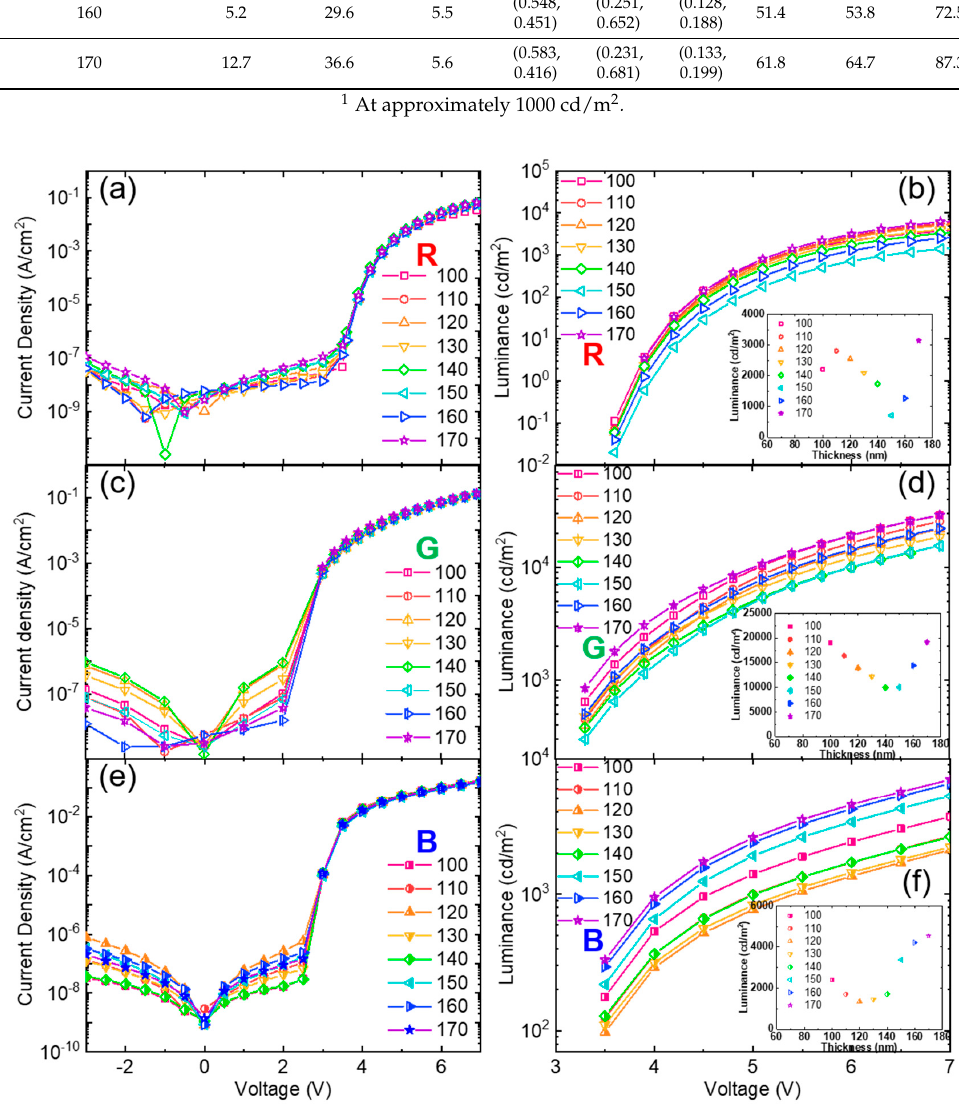
Figure 6. Current density–voltage–luminance ( J - V - L ) characteristics of ( a , b ) R, ( c , d ) G, ( e , f ) B devices with micro-cavity structure embedded cathodes depending on OSL thicknesses. Inset: Luminance of the ( b ) R, ( d ) G, ( f ) B devices at 6 V with different OSL thicknesses. Figure 7 shows the luminous current efficiency of red, green, and blue devices with micro-cavity structure embedded cathodes. The devices have different efficiencies depending on the optical length of the micro-cavity structure. The red, green, and blue devices with a 170 nm OSL have 12.7 cd/A, 36.6 cd/A, and 5.6 cd/A at approximately 1000 cd/m 2 , respectively. However, the red (OSL 150 nm), green (OSL 150 nm), and blue (OSL 140 nm) devices show 2.7 cd/A, 20.3 cd/A, and 1.8 cd/A, respectively, at about 1000 cd/m 2 . The efficiency differences of these devices arise from the different luminance caused by the micro-cavity effect. The performance parameters of the R, G, and B devices with micro-cavity structure embedded cathodes are summarized in Table 1.